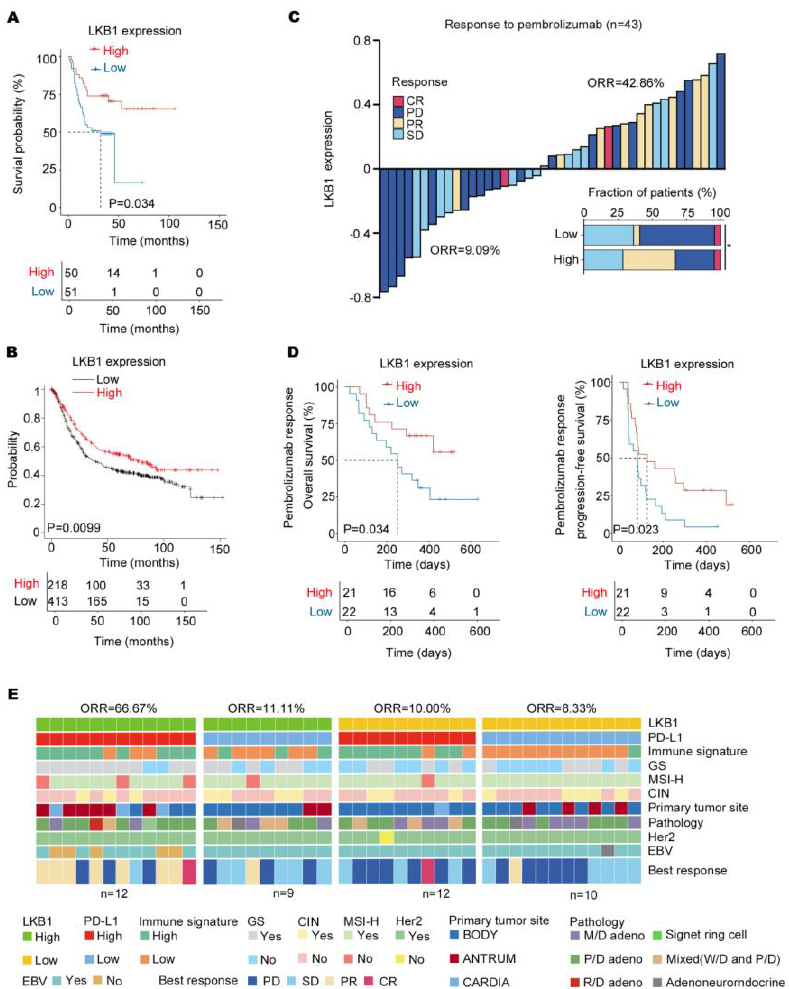
Figure 5. LKB1 expression predicts responsiveness to pembrolizumab in GC patients. ( A ) High levels of LKB1 expression were associated with prolonged survival in GC patients from 2015 to 2019. ( B ) The Kaplan −Meier Plotter showed that high levels of LKB1 prolonged the survival of GC patients. ( C ) The stacked bar and waterfall plots showing responsiveness to pembrolizumab in the ICB cohort ( n = 43) based on LKB1 expression. (Pearson’s χ 2 test). ( D ) Kaplan − Meier curves of progression − free survival (PFS) and overall survival (OS) in the ICB cohort ( n = 43) based on LKB1 expression. ( E ) Based on LKB1 mRNA expression in the subgroups of GC patients with PD − L1 high and low expression, the heatmap demonstrated responsiveness to pembrolizumab and molecular parameters in the ICB cohort ( n = 43). GS, genomically stable; MSI − H, microsatellite instability − high; EBV, EBV positive; signet ring cell: gastric signet ring cell carcinoma; ORR, objective response rate; SD, stable disease; PR, partial response; PD, progressive disease; CR, complete response; M/D adeno, moderately differentiated adenocarcinoma; P/D adeno, poorly differentiated adenocarcinoma; W/D adeno, well − differentiated adenocarcinoma; Mixed (W/D and P/D), well − differentiated adenocarcinoma and poorly differentiated